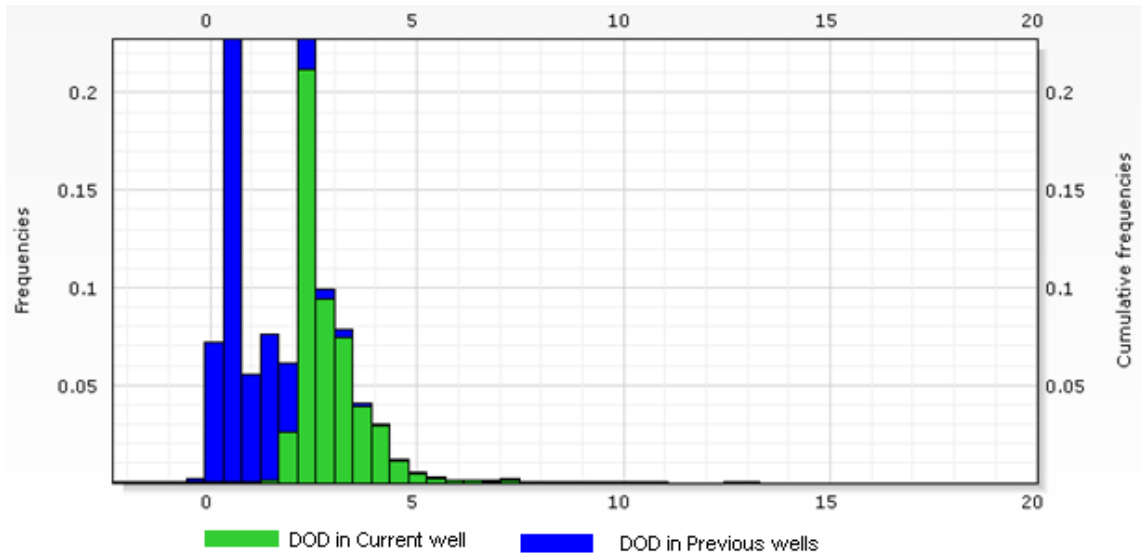
Figure 11. Comparison between the depth of damage in the current and previous drilled wells in the El Morgan Field.